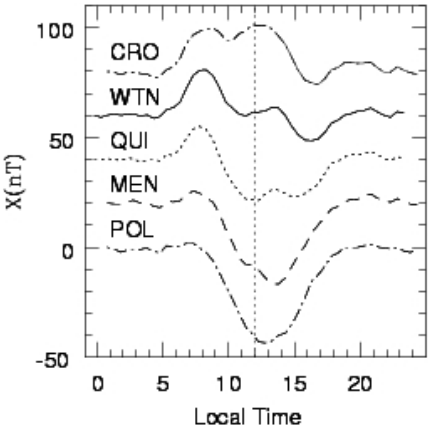
Fig. 14. X variations on 16 May 1990, plotted every half hour. Fig 14. X variations on 16 May 1990, plotted every half hour. Vertical line indicates time of focus passage. As for Fig 2. Vertical line indicates time of focus passage. As for Fig.